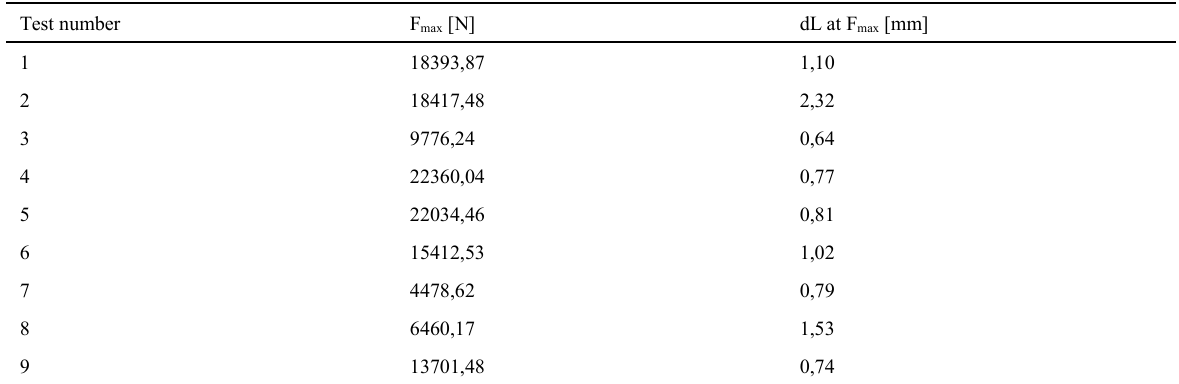
Table 6: Mechanical test